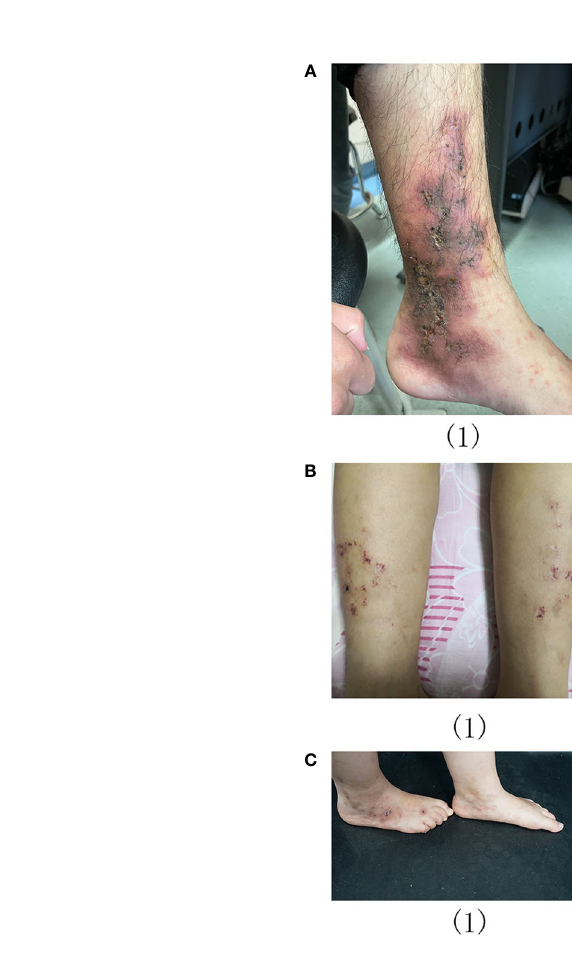
FIGURE 2 Livedoid vasculopathy before (1) and after (2) baricitinib treatment in patients 2 (A) , 5 (B) , and 8 (C)